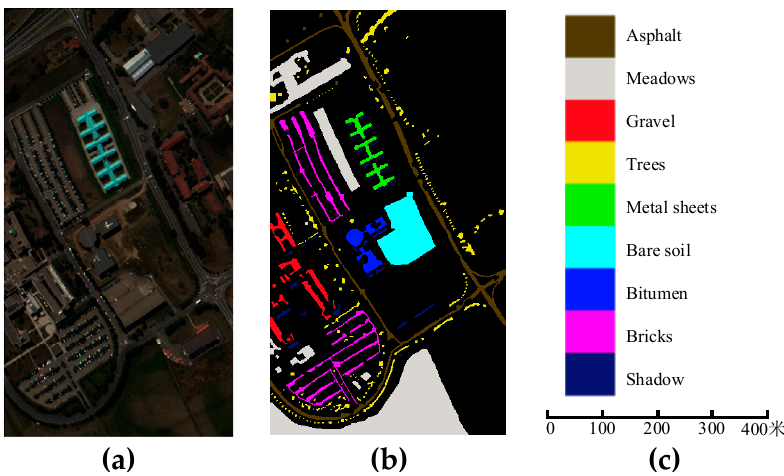
Figure 5. The Pavia dataset. ( a ) False-color composite image; ( b ) ground truth map; ( c ) scale bar. For the Indian Pines dataset, it was captured by the AVIRIS sensor over the Indian Pines region in Northwestern Indiana, 1992. The spatial size of it is 145 × 145 with the spatial resolution of 20 m. The number of spectral bands is 200 with the wavelengths from 0.4 to 2.5 µ m after discarding 20 water absorption bands. Sixteen ground truth classes are labeled in the available ground truth. The false-color composite image, the available ground-truth map, and the scale bar are shown in Figure 6.